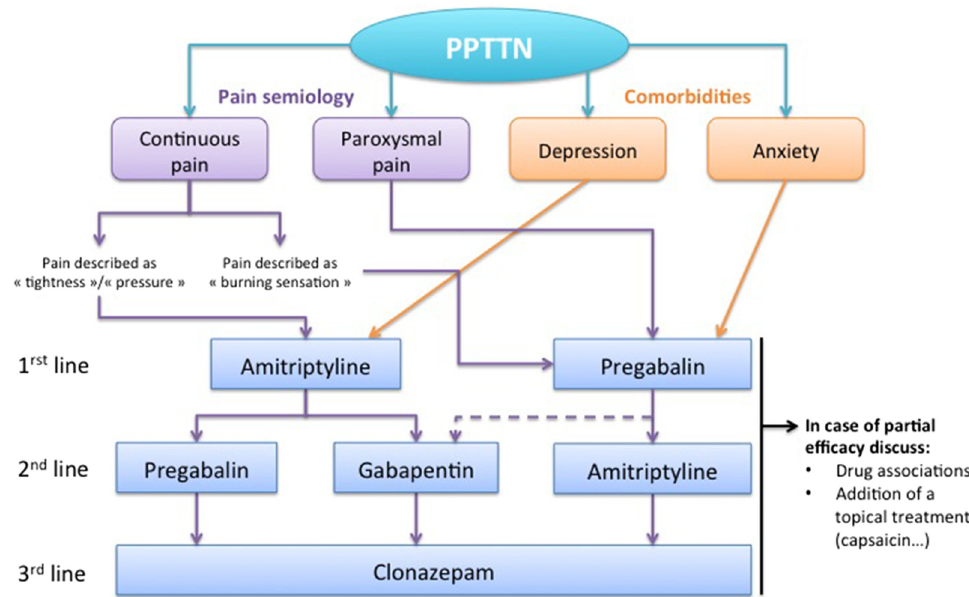
Figure 5. Therapeutic algorithm for the pharmacological treatment of Painful Post-Traumatic Trigeminal Neuropathy (PPTTN). Algorithm developed according to the patient cohort and to French [9] and European guidelines